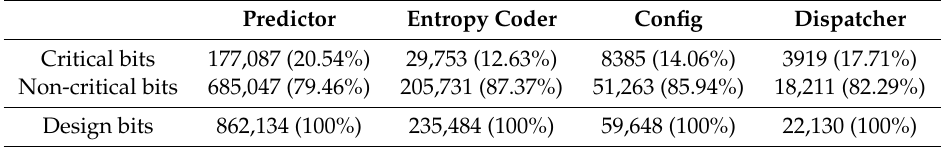
Table 1. Intrinsic reliability of the different modules of the CCSDS 123.0-B-1 IP core (synthetic image).